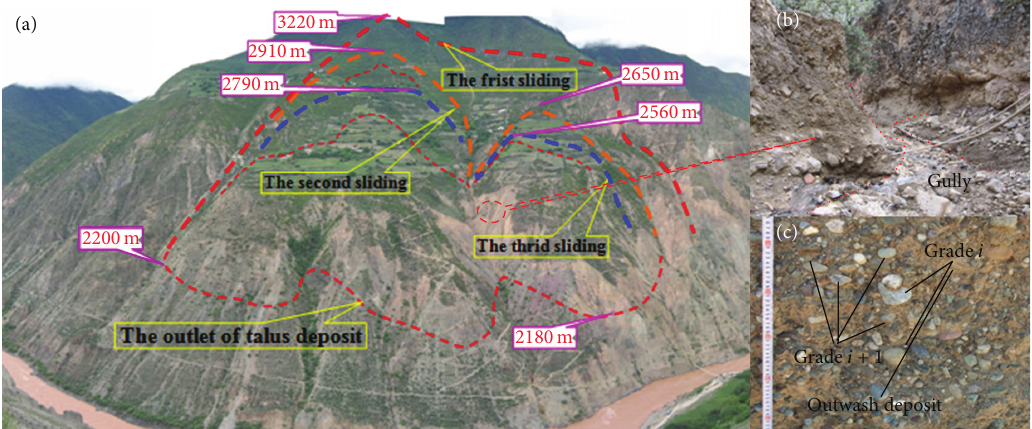
Figure 1: A typical outwash deposit formed by glacial